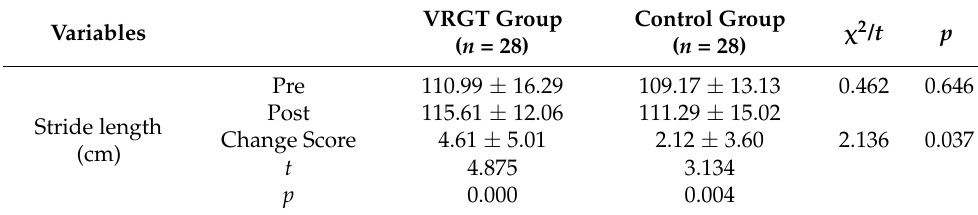
Table 4. Changes of spatial gait